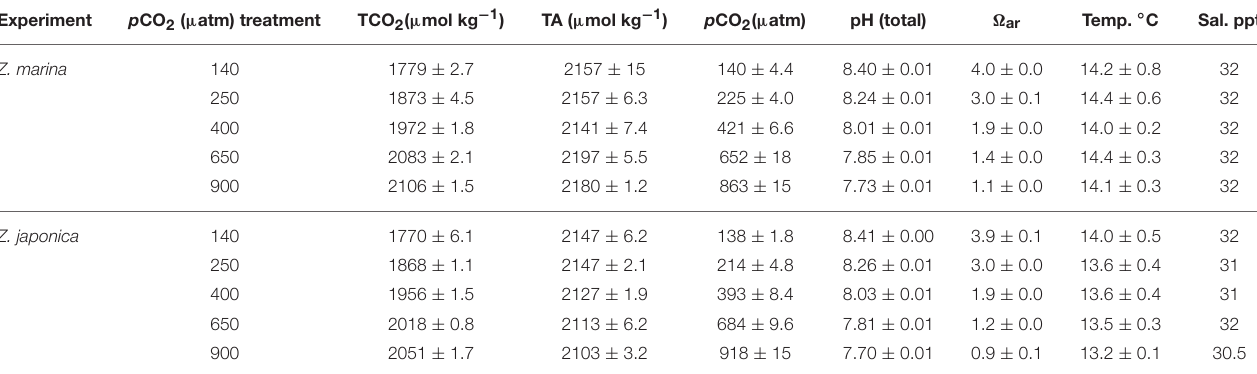
TABLE 1 | Initial conditions for both Z. marina and Z. japonica experiments.